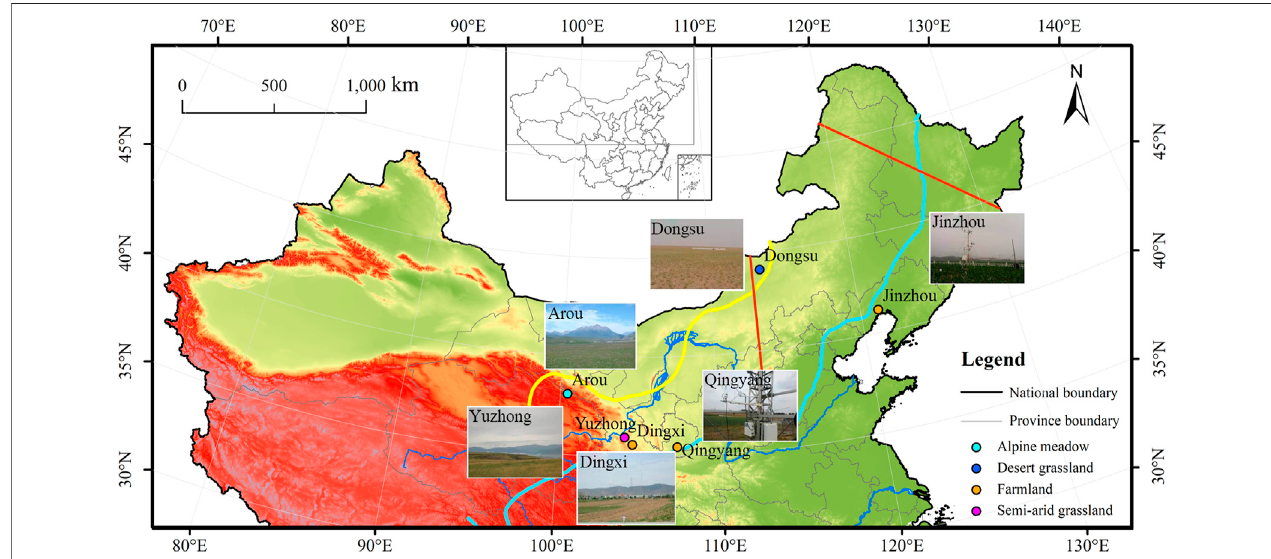
FIGURE 1 | Geographical location of the study area. The dots show the observation stations. The regions separated by the red lines, from right to left, are the northern region, the eastern region, and the western region.